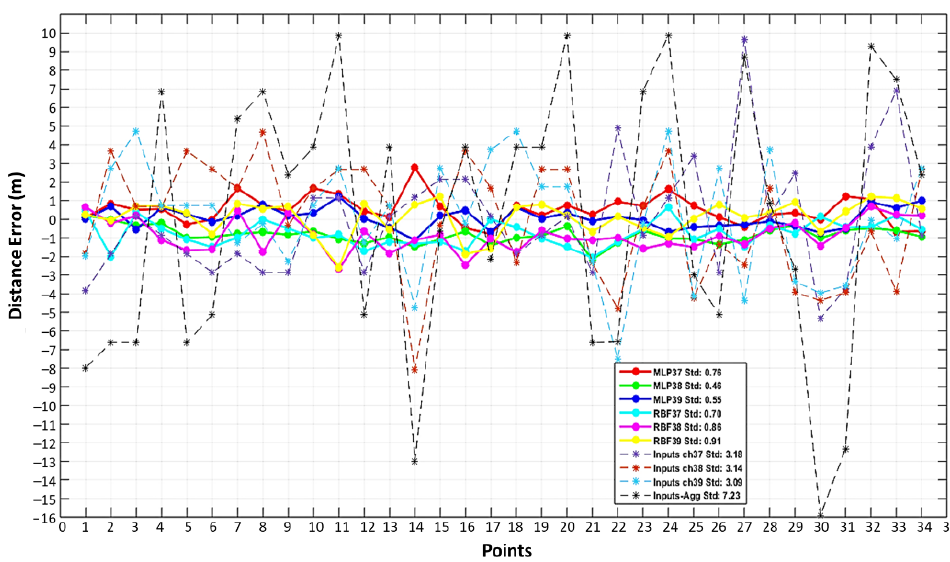
Figure 16. Mean of the distance error for each reference point for transmitter #1.